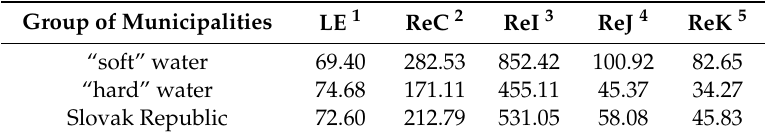
Table 2. Values of the main health indicators. LE is given in years and ReC, ReI, ReJ, ReK as the number of cases per 100,000—standard SR